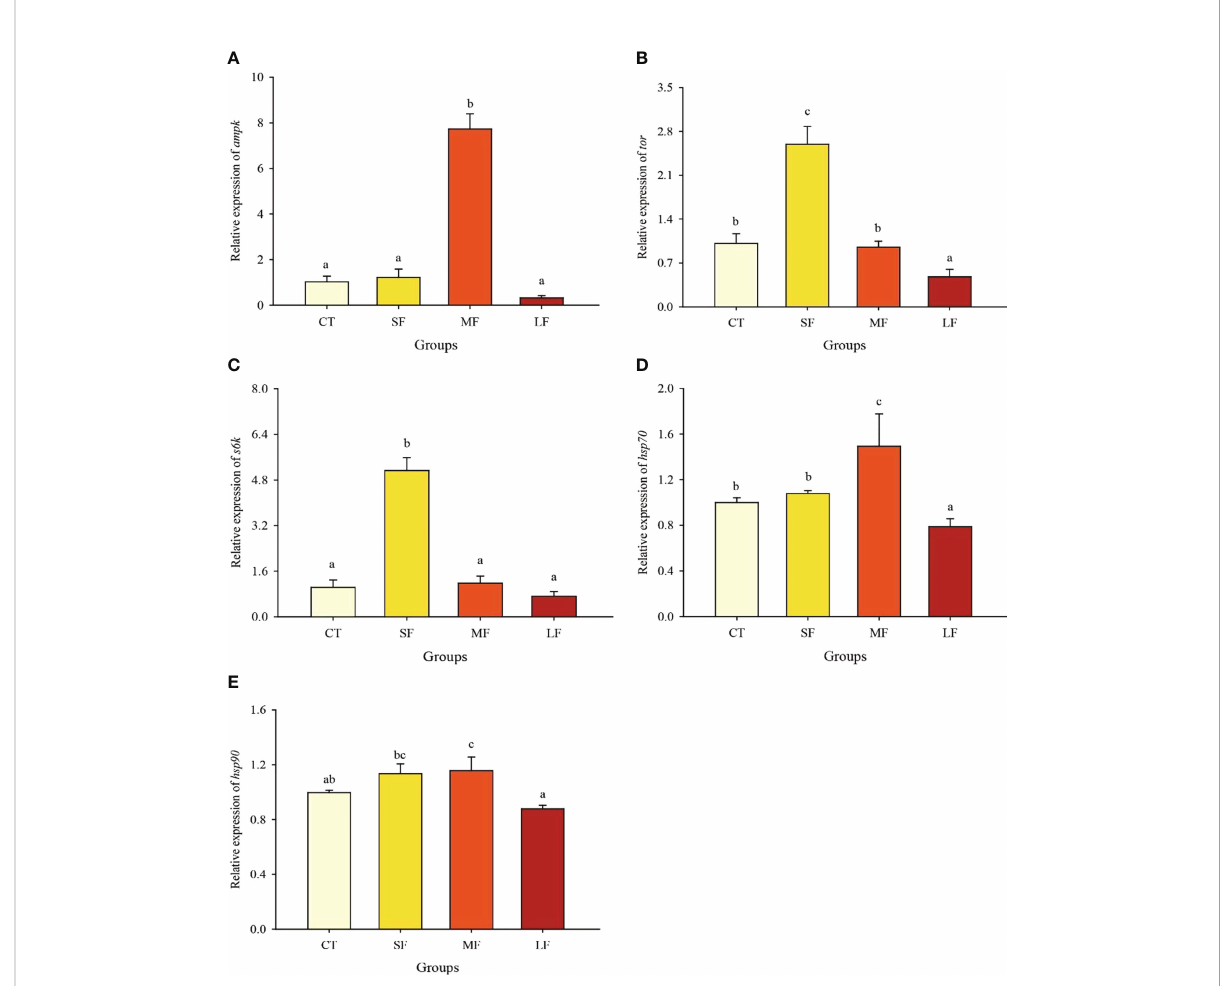
FIGURE 4 Relative expression of ampk (A) , tor (B) , s6k (C) , hsp70 (D) and hsp90 (E) in the hepatopancreas of juvenile crabs. Values are expressed as mean ± SD (n = 3). Different superscripts indicate signi fi cant differences between treatments ( P <